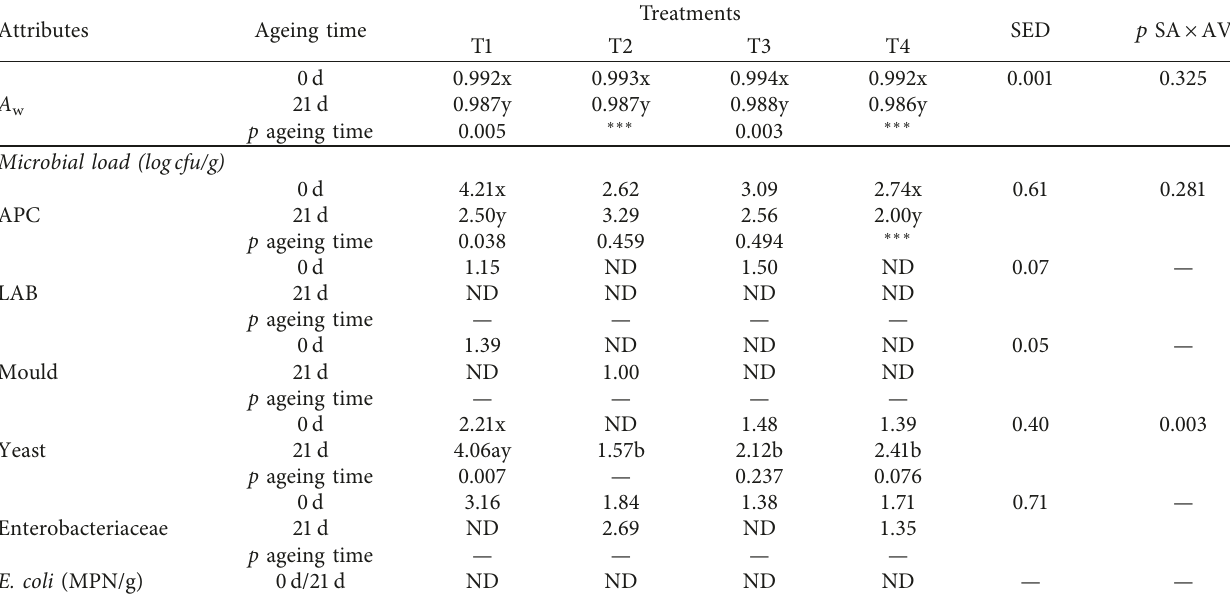
Table 6: Effect of ageing treatments and ageing time on A beef.